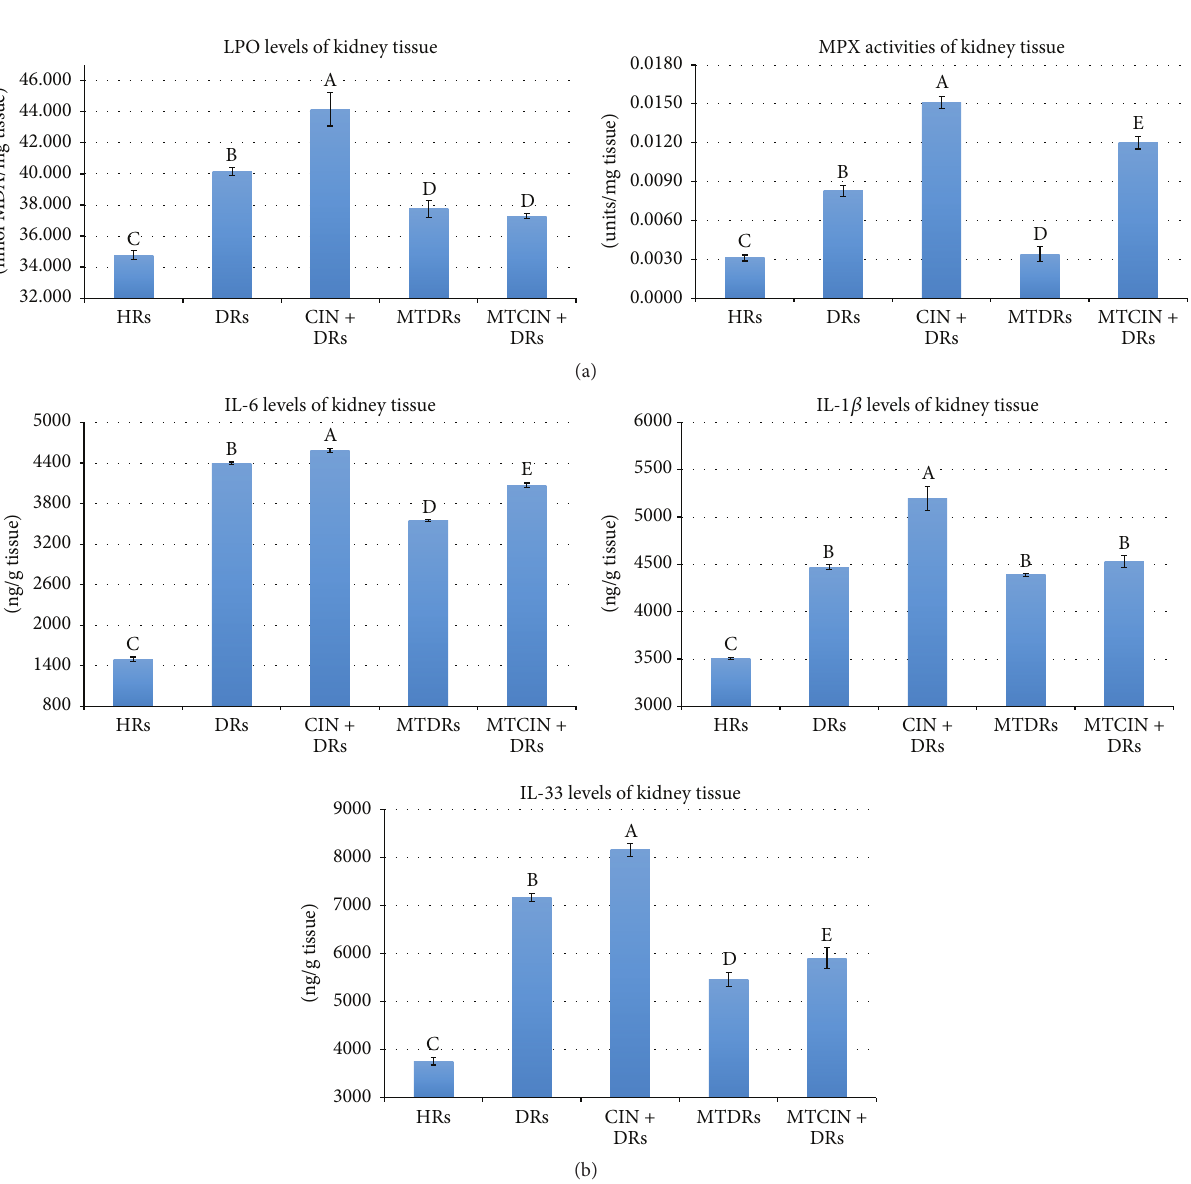
Figure 1: (a) The oxidative stress markers of groups. A: 𝑝 < 0.05 for CIN + DRs versus HRs, and DRs regarding LPO and MPX levels. B: 𝑝 < 0.05 for DRs versus HRs, regarding LPO and MPX levels. C: 𝑝 < 0.05 for HRs versus MTDRs and MTCIN + DRs, regarding LPO